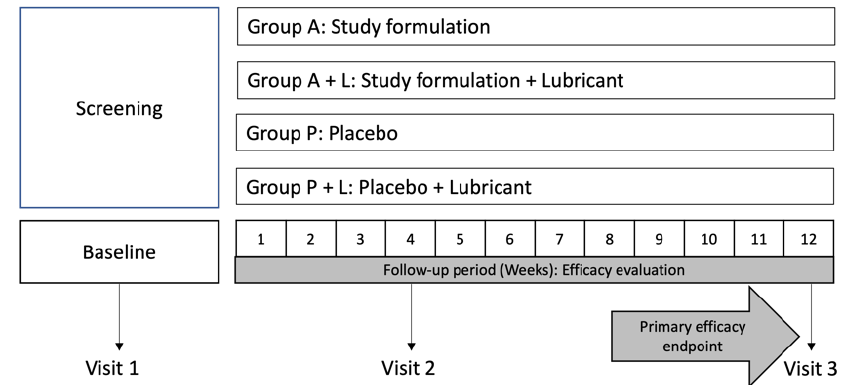
Figure 2. Efficacy study design. Each subject underwent baseline visit (visit 1) and was randomly assigned to 1 of 4 groups: A (study formulation), A + L (study formulation + lubricant), P (Placebo), and P + L (Placebo + lubricant). Follow-up lasted 12 weeks for all efficacy study groups. The evaluation was done using the OSDI questionnaire scoring. For the objective evaluation, all eligible participants underwent an ophthalmologic examination, including BCVA measurement with the ETDRS chart, and a full slit lamp clinical evaluation. The evaluation was performed at baseline, week 4, and week 12 and it